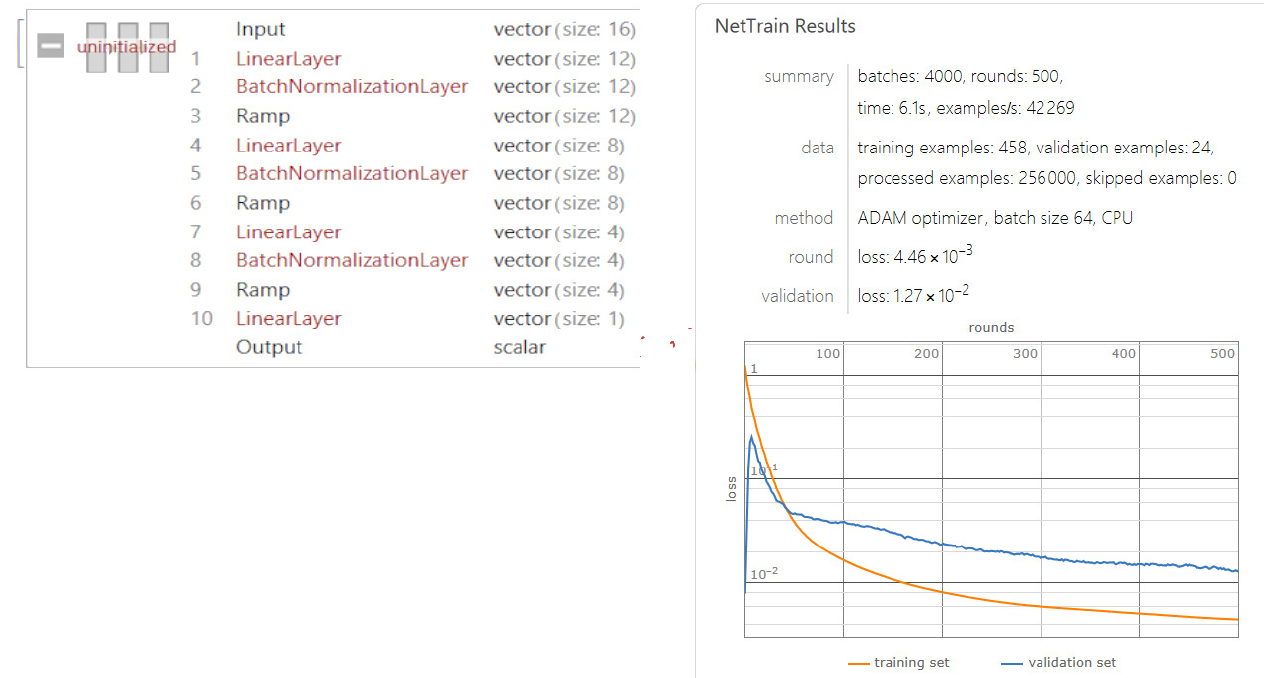
Figure A2. An example of a 10-layer network. The input of the network indicates a 16-dimensional vector—the size of state-space of the price changes and the scalar output—training on, or prediction of, one of the three monthly indexes.